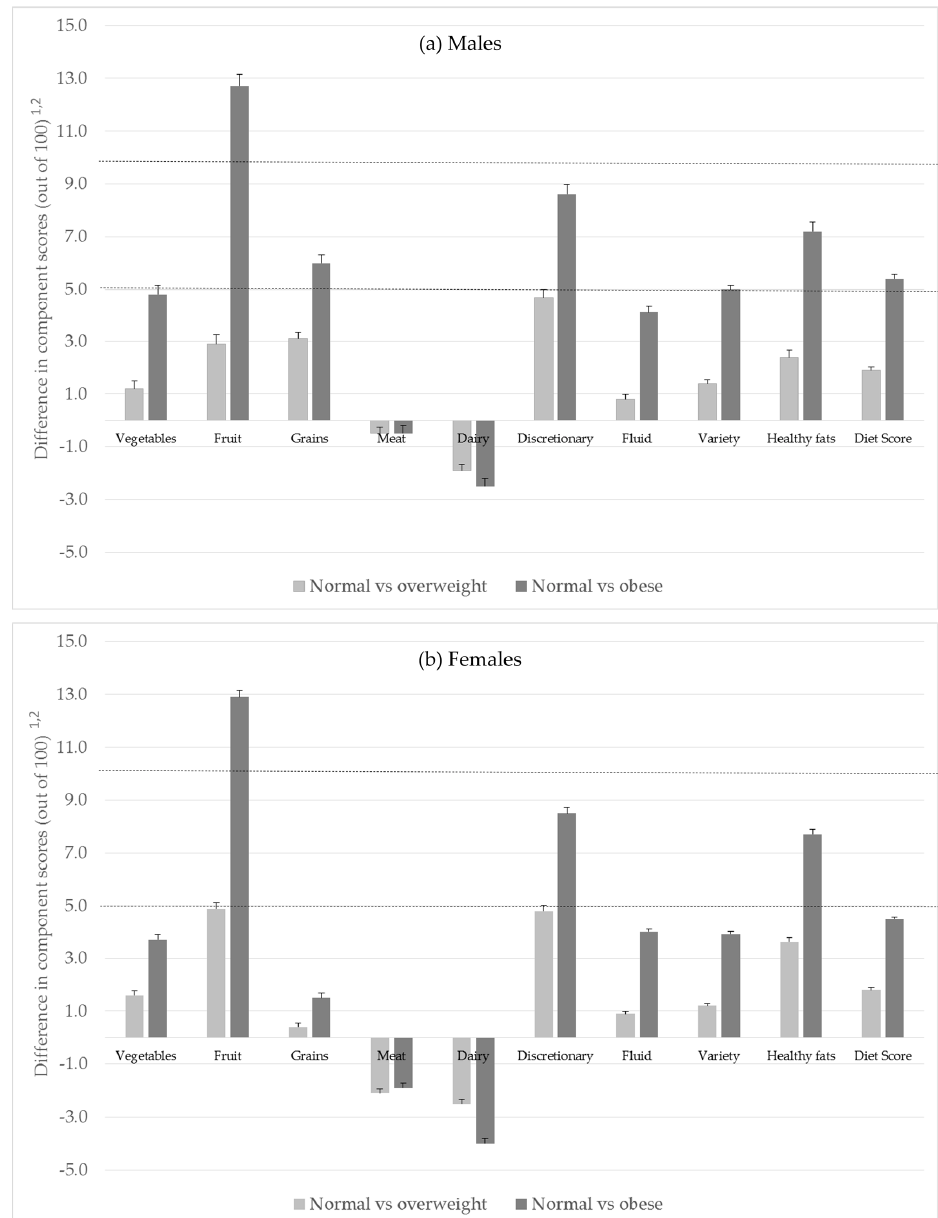
Figure 2. Differences 1,2 in compliance scores (mean difference plus standard error) between normal and overweight (light grey), and normal weight and obese adults (dark grey), by gender ( a ) Males, ( b ) Females. 1 A positive difference score means normal weight has a higher score and therefore greater compliance with Dietary Guidelines. 2 A difference of less than 5 points is considered small, 5 to less than 10 medium, and 10 or more a large difference. The dotted horizontal lines are positioned at 5 and 10 points.